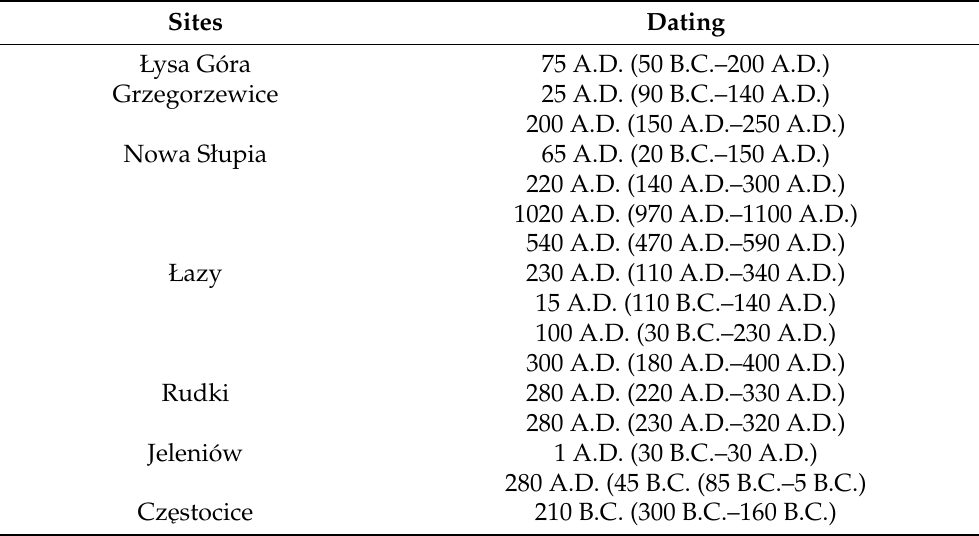
Table 1. Dating of charcoal and slag samples from localities: Łysa Góra, Grzegorzewice, Nowa Słupia, Łazy, Rudki, Jelenów, and Cz˛estocice [23].